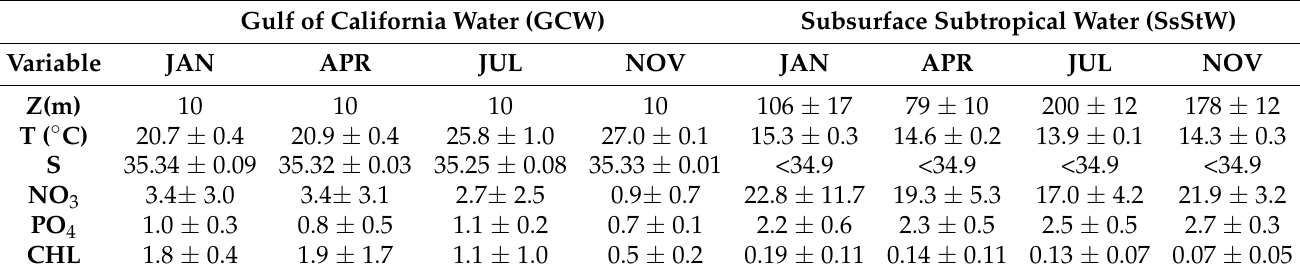
Table 1. Water masses in Bahía de La Paz (BLP) based on data obtained in 2002, GCW and SsStW. Gulf of California Water (GCW) Subsurface Subtropical Water (SsStW) Variable